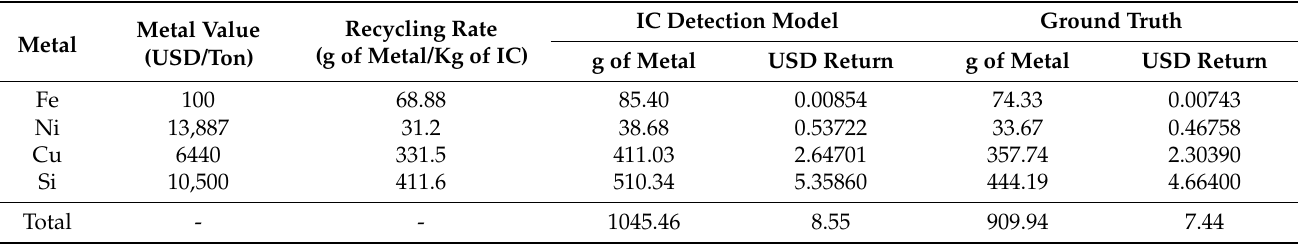
Table 5. Total IC recycling estimation outcomes.